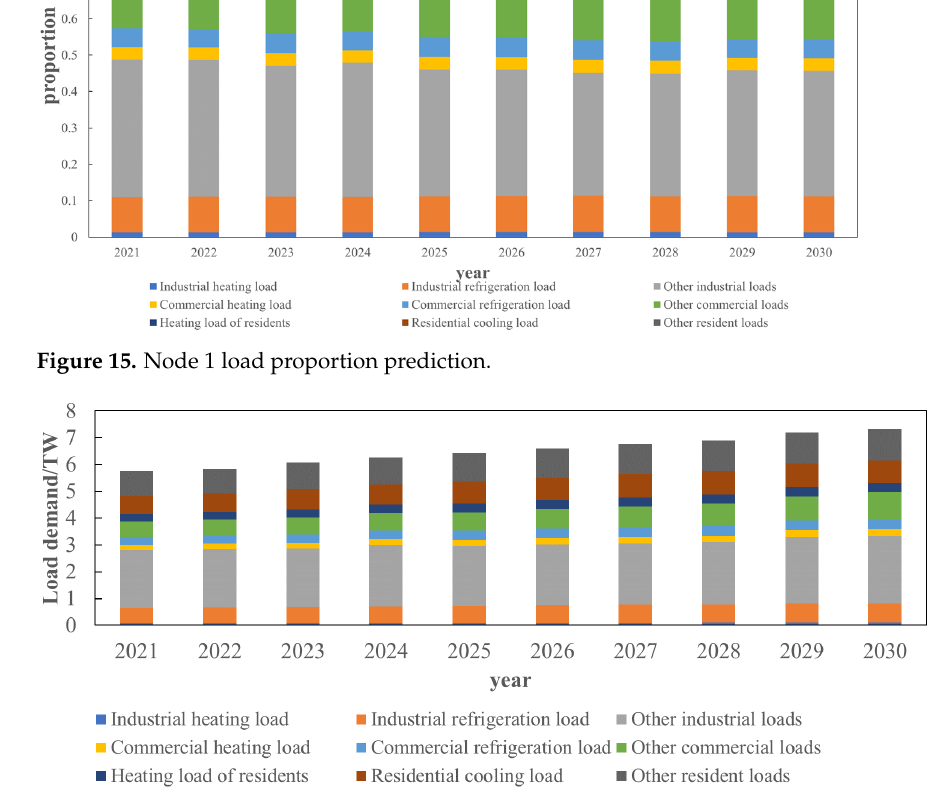
Figure 16. Node 1 load prediction by type.